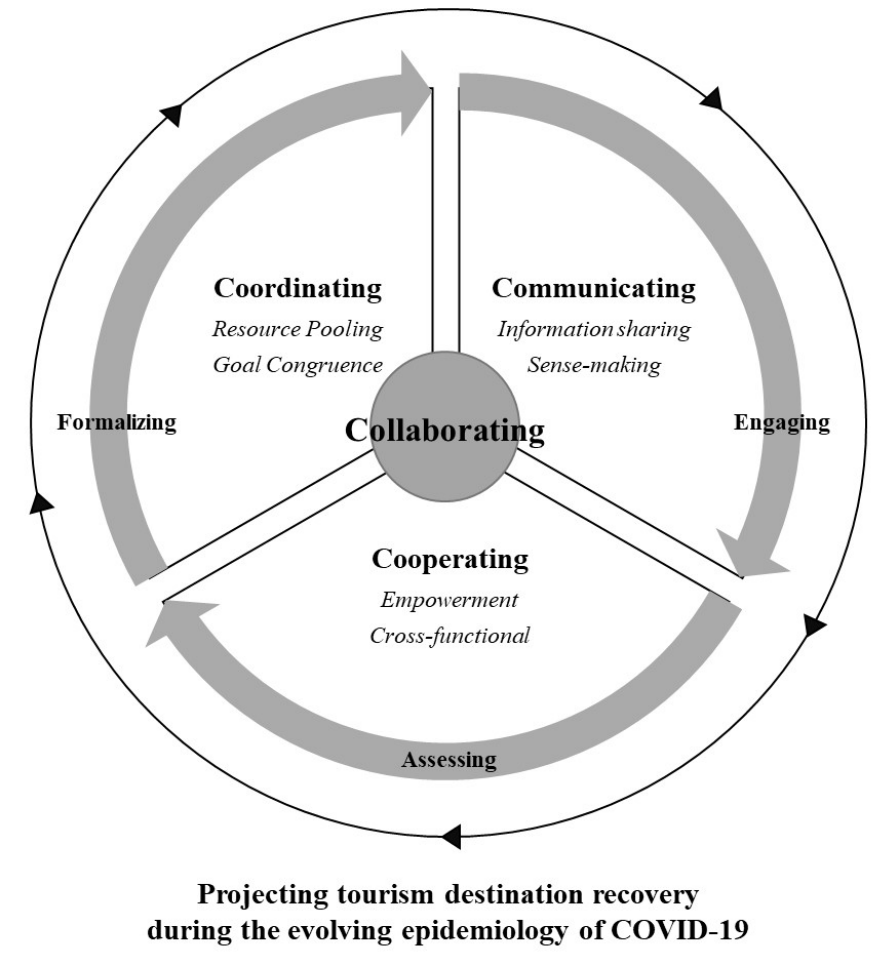
Figure 3. Framework for collaborative practice for tourism destination recovery (adapted from [40] Schuh et al., 2014). Schuh et al.,